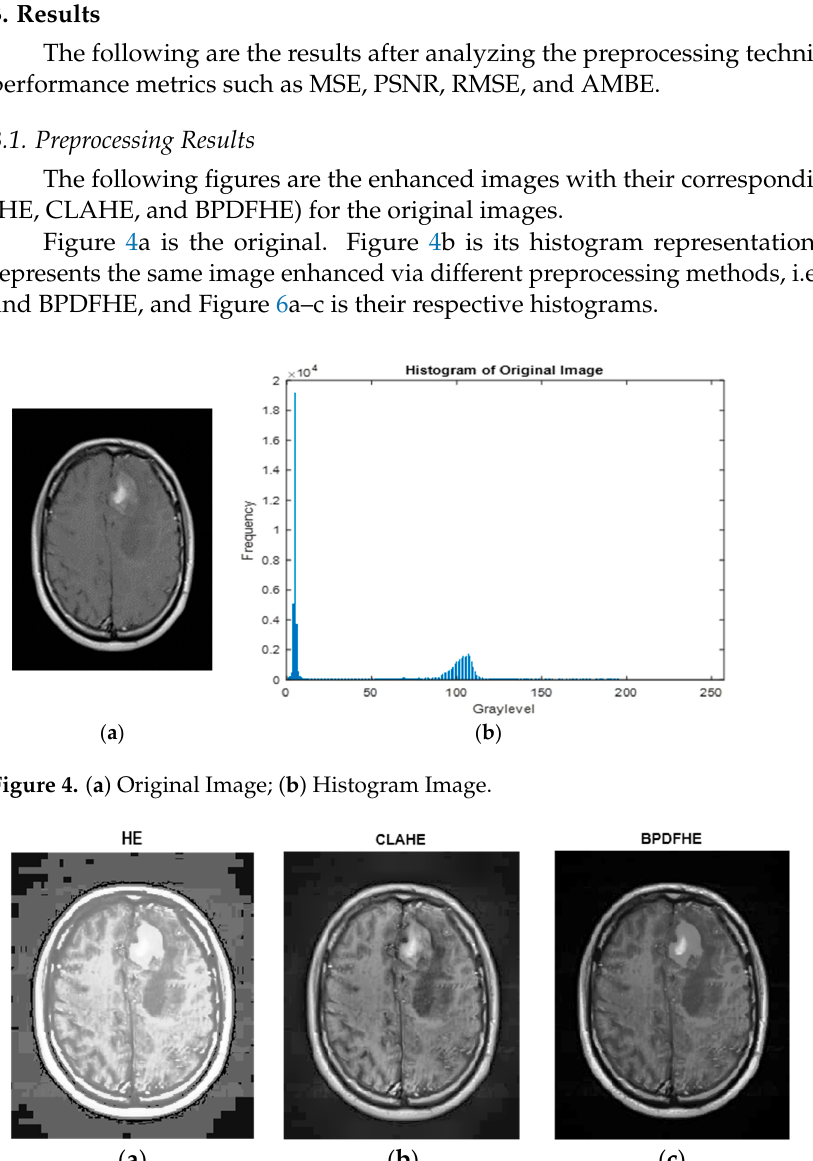
Figure 5. Preprocessed with ( a ) HE, ( b ) CLAHE, and ( c ) BPDFHE.